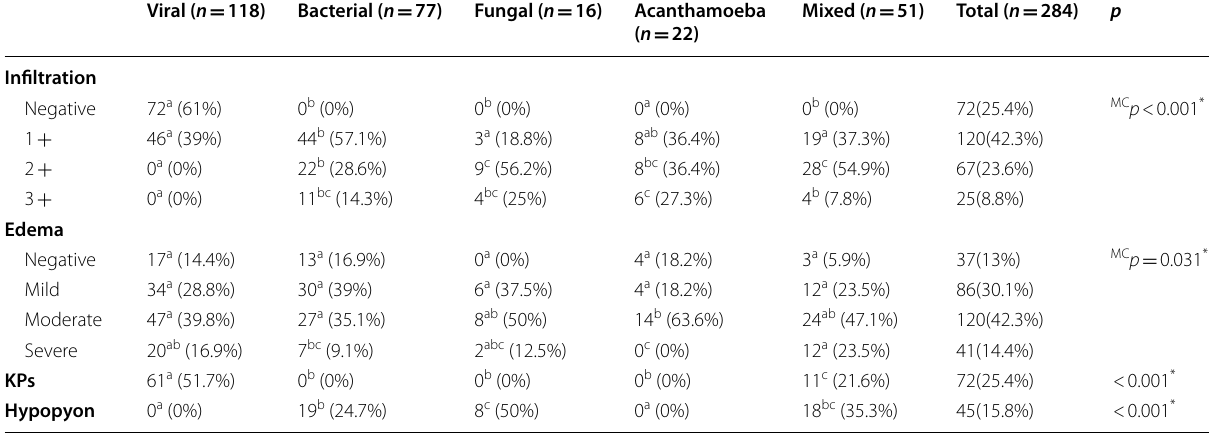
Table 6 Comparison between MK groups according to baseline characteristics of specific corneal features